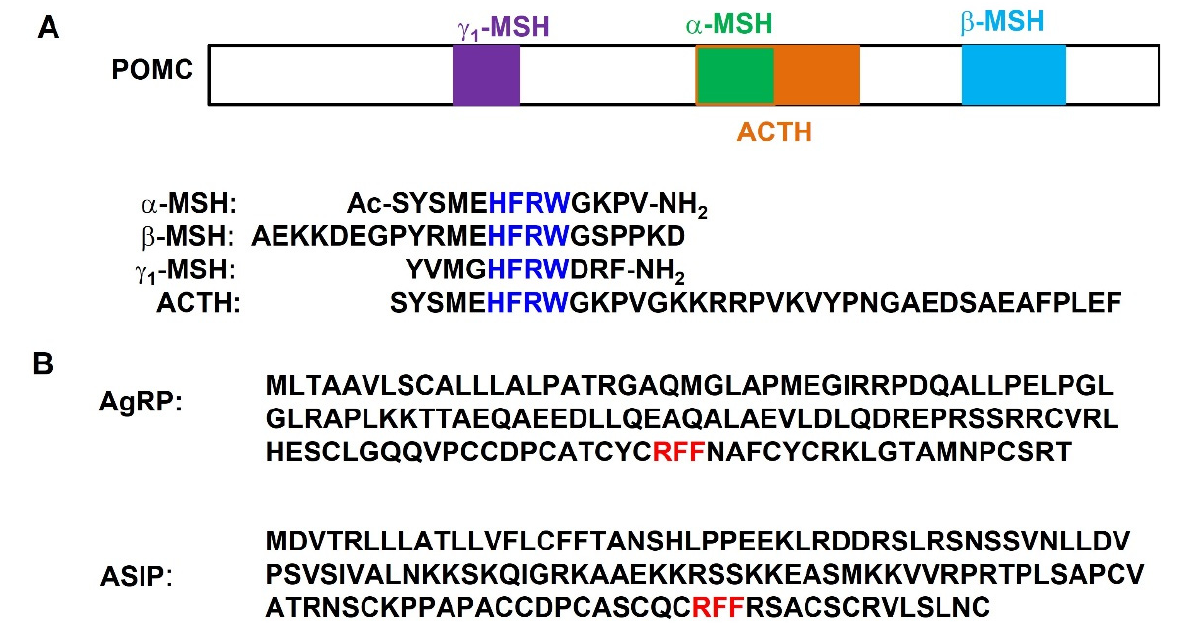
Figure 1. Endogenous ligands for melanocortin receptors. ( A ) Schematic diagram of POMC and sequences of four agonists; ( B ) sequences of two antagonists. The HFRW motif is shown in blue. The RFF motif is highlighted in red. Table 1. Pharmacological properties of endogenous ligands at human melanocortin receptors. Binding Affinity [28,29]